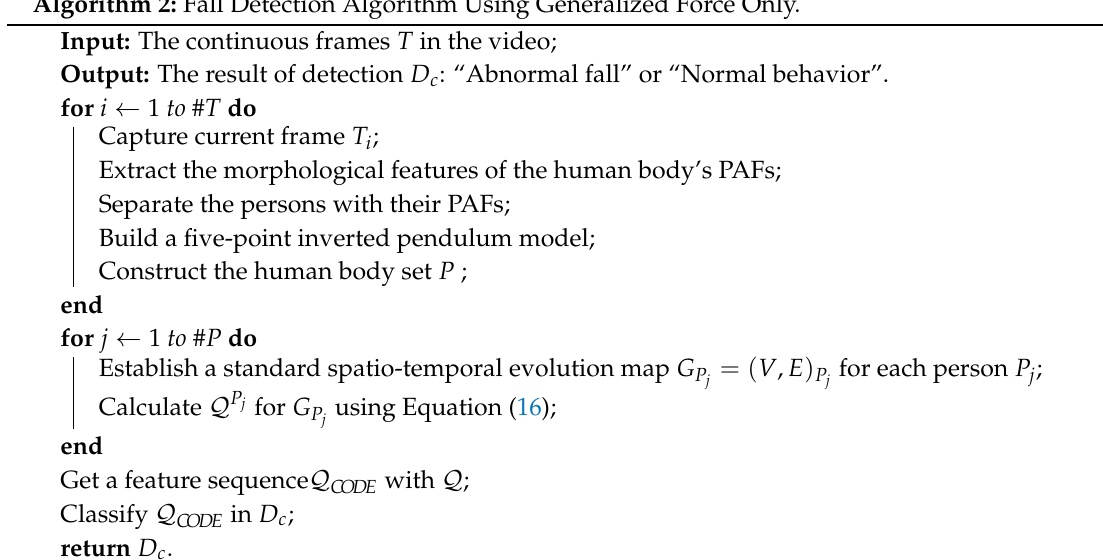
Algorithm 2: Fall Detection Algorithm Using Generalized Force Only.